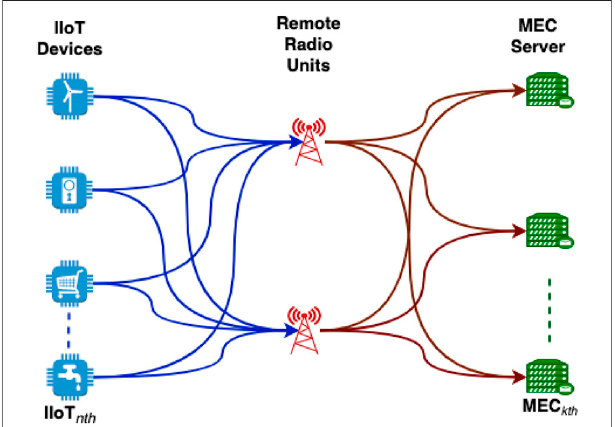
FIGURE 2 | IIoT to MEC DAG